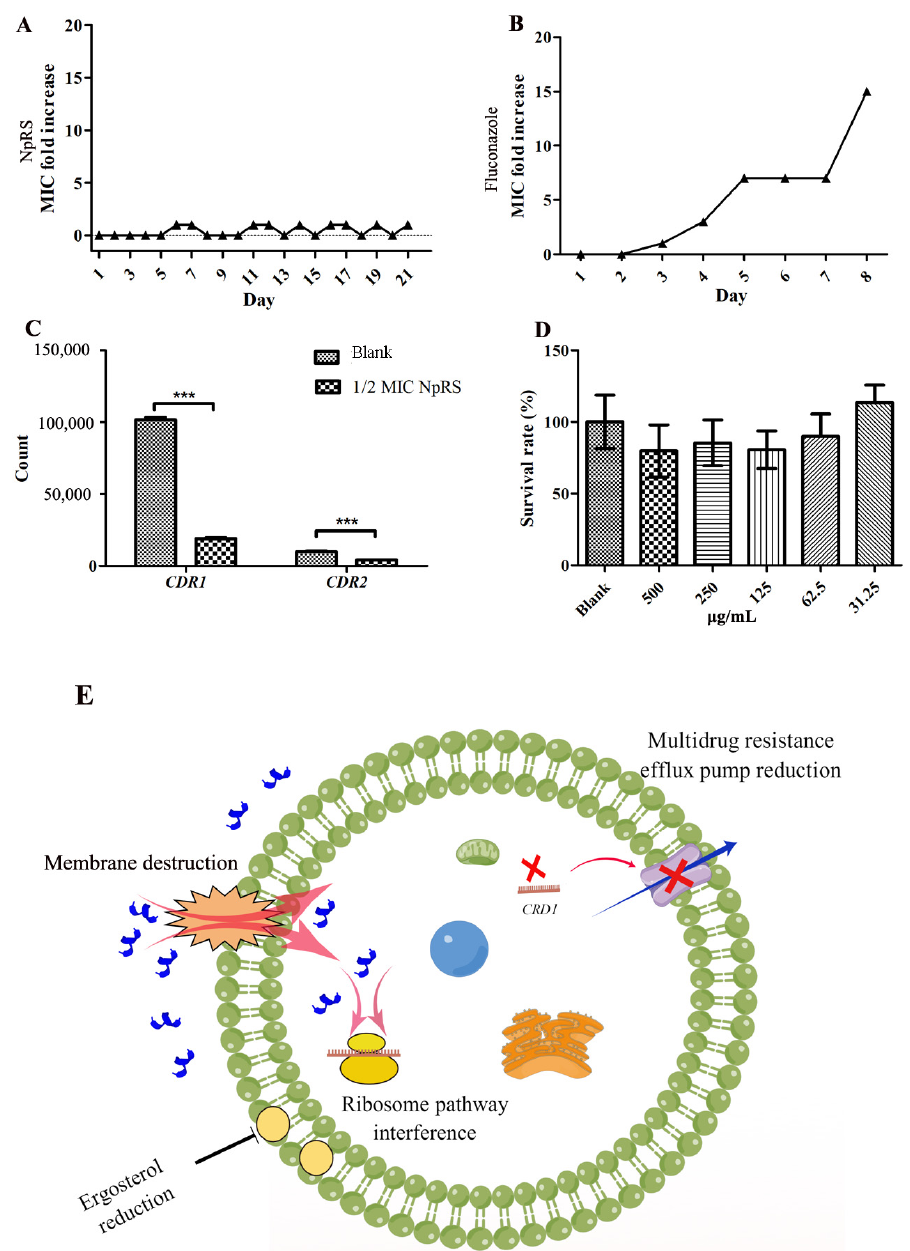
Figure 6. Drug resistance analysis and cell cytotoxicity to mammalian cells. ( A ) Gene counts of CDR1 and CDR2 ; ( B ) MIC folds increase of fluconazole in 8 days; ( C ) MIC folds increase of NpRS in 21 days; ( D ) Cell cytotoxicity of NpRS to mammalian L6 cells; ( E ) Proposed antifungal mechanisms of NpRS against C. albicans . All data were expressed as the mean values of triplicate ± standard deviation. *** p < 0.001, compared with blank control.